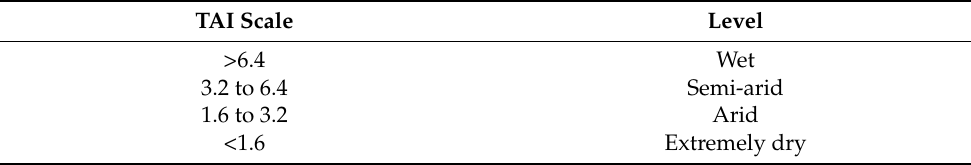
Table 3. Thornthwaite aridity index (TAI) values and corresponding aridity levels [41].